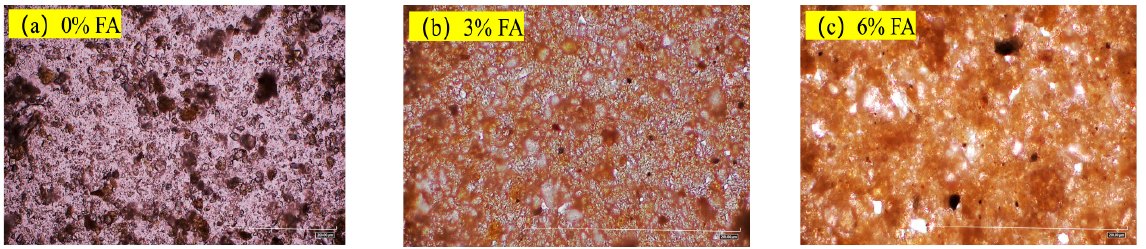
Figure 2. Effect of FA on the consistency limit of sludge: ( a ) liquid limit and plastic limit; ( b ) plastic- ity diagram.